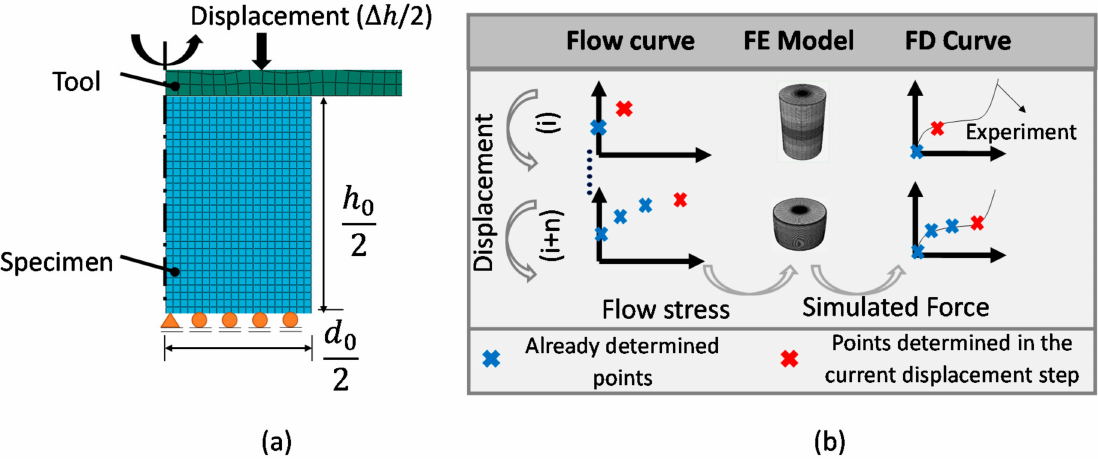
Figure 2. ( a ) Schematic of the finite element (FE) Model and ( b ) illustration of the concept of consecutive flow curve point